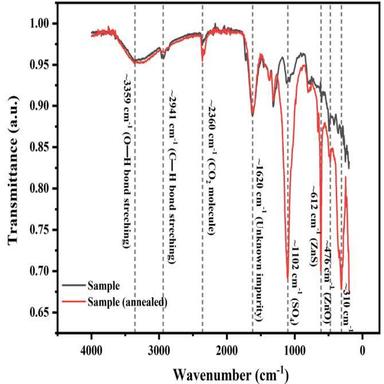
FTIR spectra of as received and annealed powder.